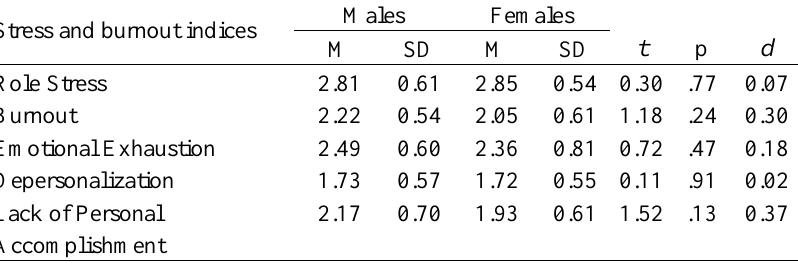
Means, standard deviations and differences by sexes of stress and burnout Stress and burnout indices